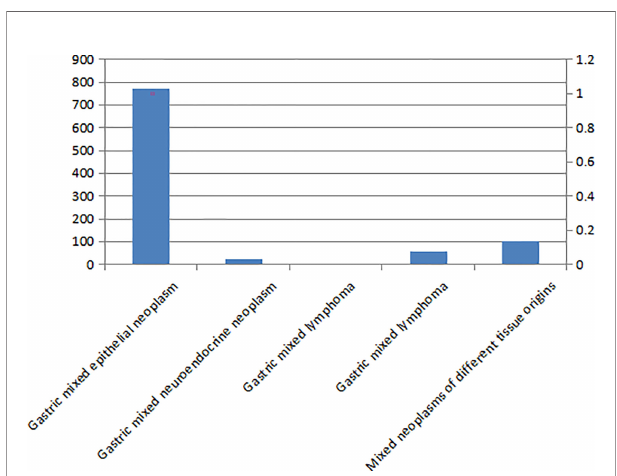
FIGURE 2 | Common distribution of gastric mixed